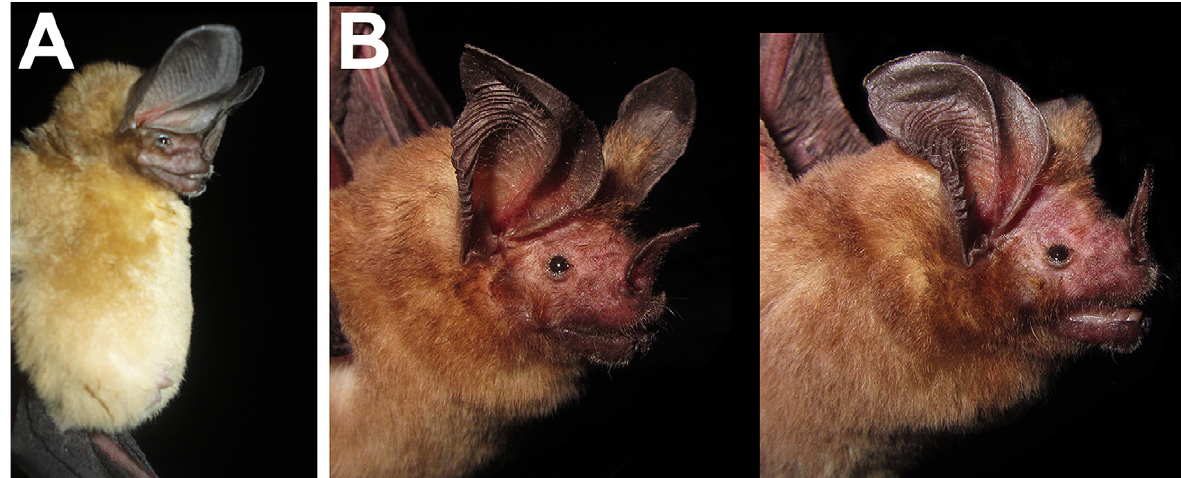
Figure 2. Lophostoma brasiliense A. Adult female (individual was released) from RPPN Foz do Aguapeí (São Paulo, Brazil); B. Adult male (LMUSP 512) from Caiuá (São Paulo, Brazil) showing the “ear curling” behavior typical of the genus.